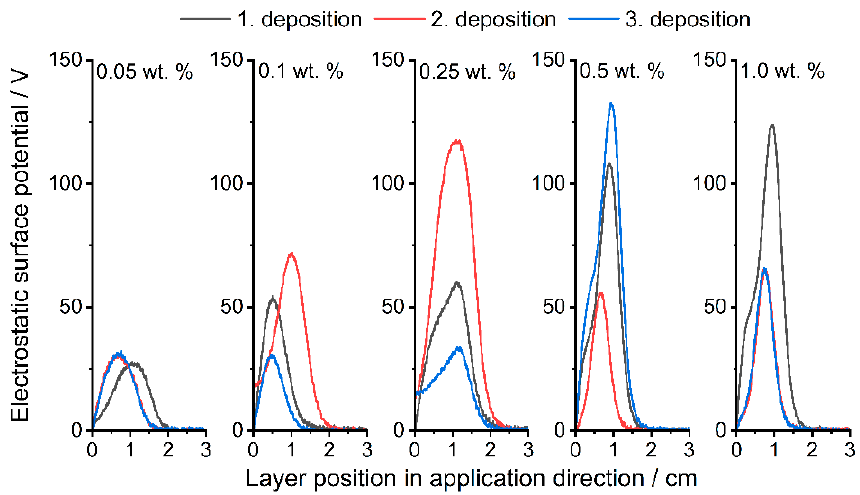
Figure 6. Measured ESP at different layer positions. Comparison between the Silica(+) formulations; increasing content from left to right.